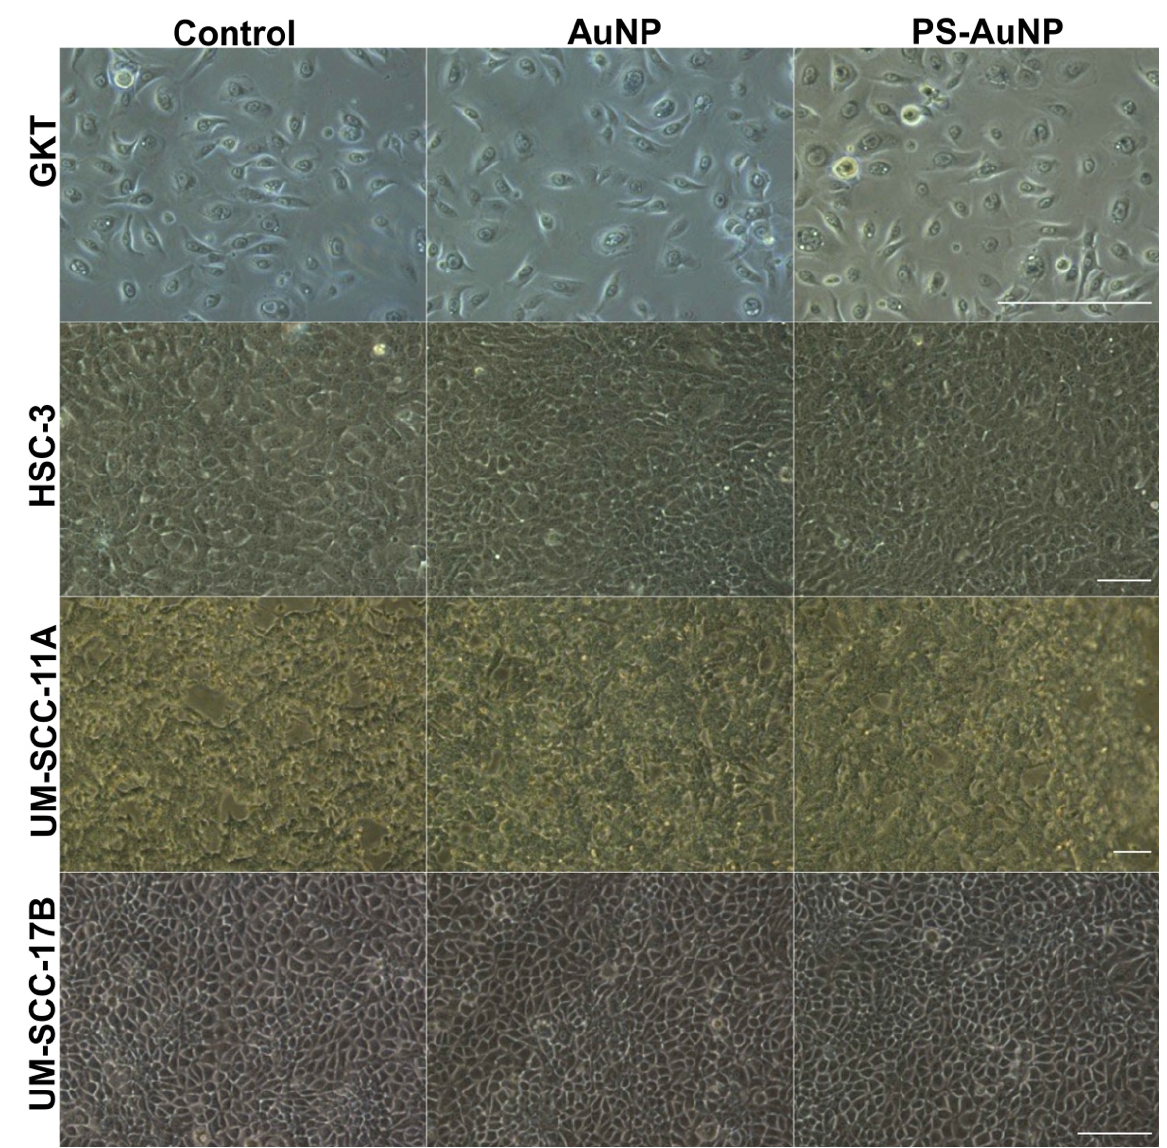
Figure 5. PS-AuNPs do not induce significant morphological changes in oral cancer cells. From top to bottom rows, light microscopy of the cell morphology of GKT normal gingival keratinocyte cell line and the oral cancer cell lines HSC-3, UM-SCC-11A, and UM-SCC-17B. The left column shows cell lines challenged with PBS; the central column shows cell lines challenged with AuNP; and the right column shows cell lines challenged with PS-AuNP. Scalebar equivalent to 50 µm.